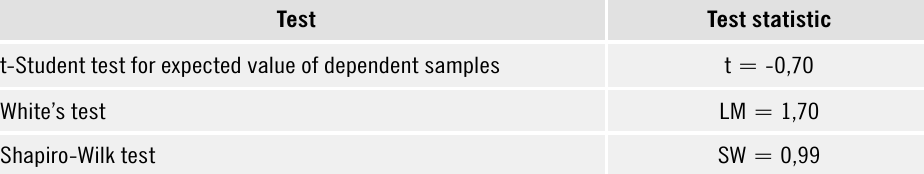
Table 7. Results of OLS assumptions diagnostics test for SDI against GP _ all Test Test statistic t-Student test for expected value of dependent samples t = -0,70 White’s test LM = 1,70 Shapiro-Wilk test SW =